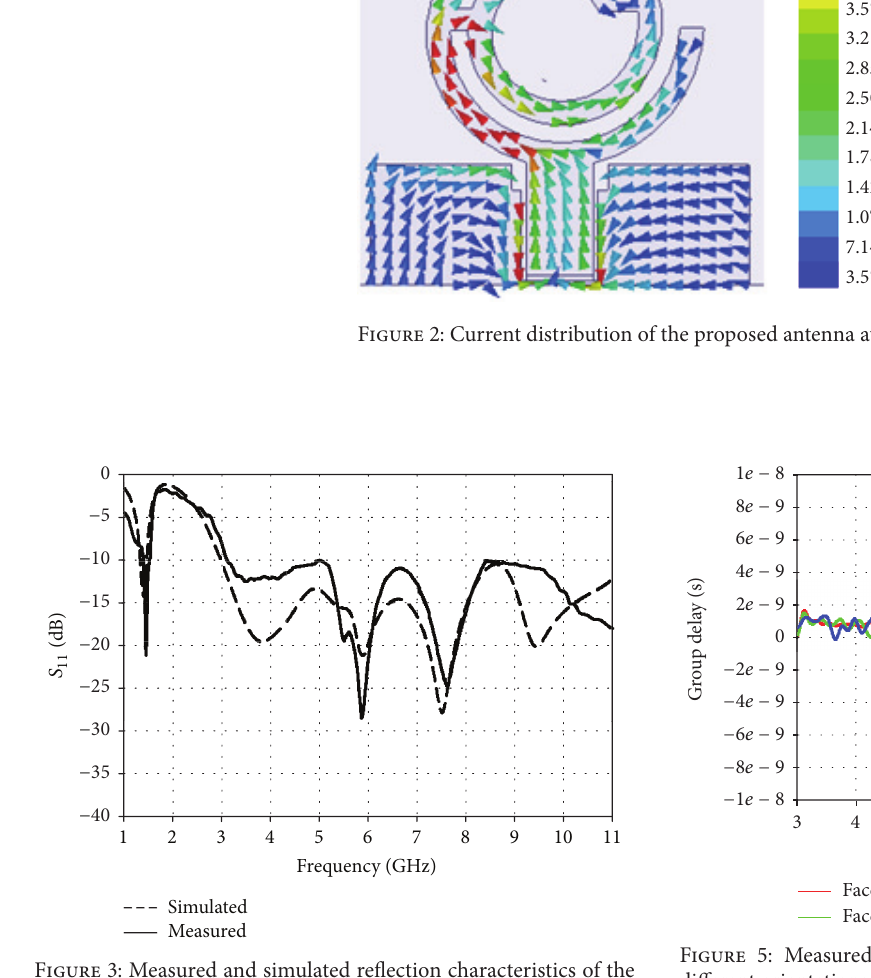
Figure 3: Measured and simulated reflection characteristics of the proposed antenna.